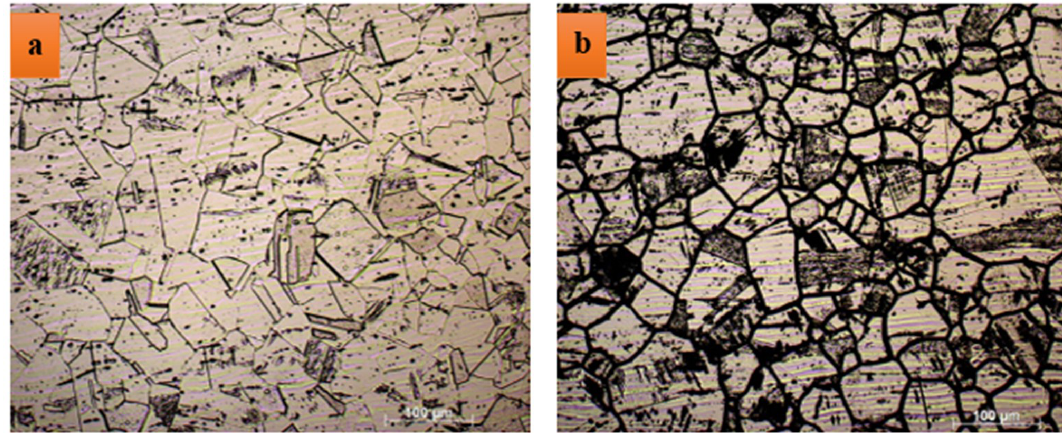
Figure 4. Optical microscope images of grain structure in ( a ) base metal and ( b ) HAZ area of failed specimen, etched according to standard ASTM A262, Practice A.